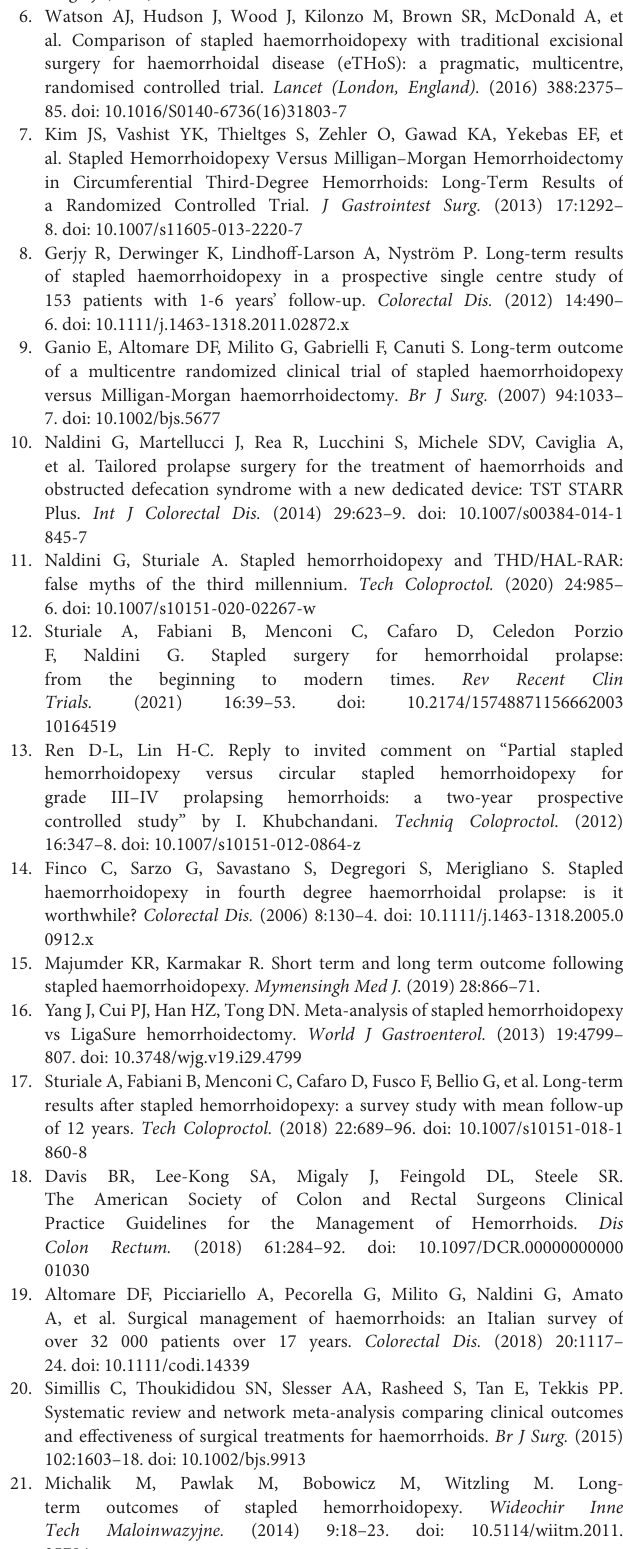
for asymmetric muco-hemorrhoidal prolapse: an observational study of 433 consecutive